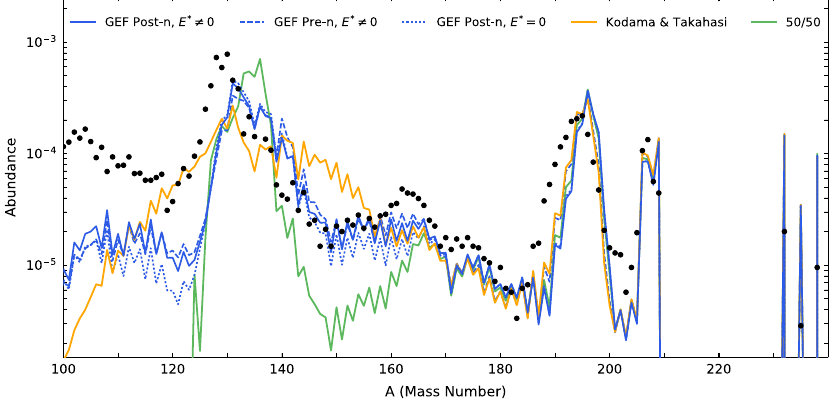
Figure 2. Nucleosynthesis calculation abundances at 1 Gyr as a function of mass number for cold dynamical ejecta conditions as can be found in a merger tidal-tail [25] using di ff erent prescriptions for the fission yields of neutron-rich nuclei: GEF2016 [22] (blue), Kodama & Takahashi [26] (yellow), and 50 / 50 symmetric yields where it is assumed that the nucleus simply splits in half (green). The dashed blue line examines the impact of ignoring prompt neutron emission by applying pre-neutron emission yields. The dotted blue line considers results when the excitation energy dependence of yields is ignored ( E ∗ = 0). Black dots are the solar abundance data from